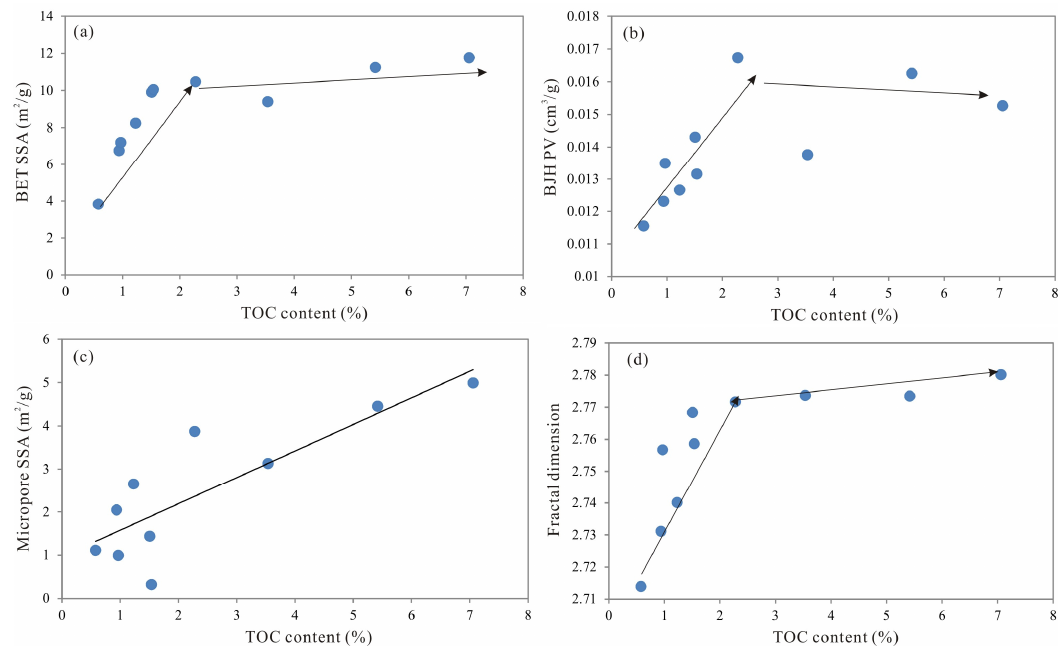
Figure 7. Effect of TOC content on pore structure parameters in Niutitang shale: ( a ) Brunauer-Emmett-Teller specific surface area (BET SSA); ( b ) Barrette-Joynere-Halenda pore volume ( BJH PV); ( c ) Micropore SSA (obtained using the t-plot method based on N 2 adsorption); ( d ) Fractal dimension.